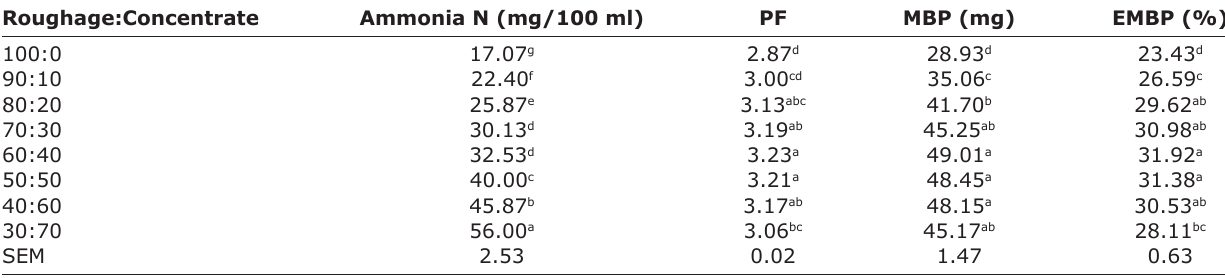
Table-4: Effect of MS to concentrate ratio on PF, EMBP, and ammonia-nitrogen in Deccani sheep.